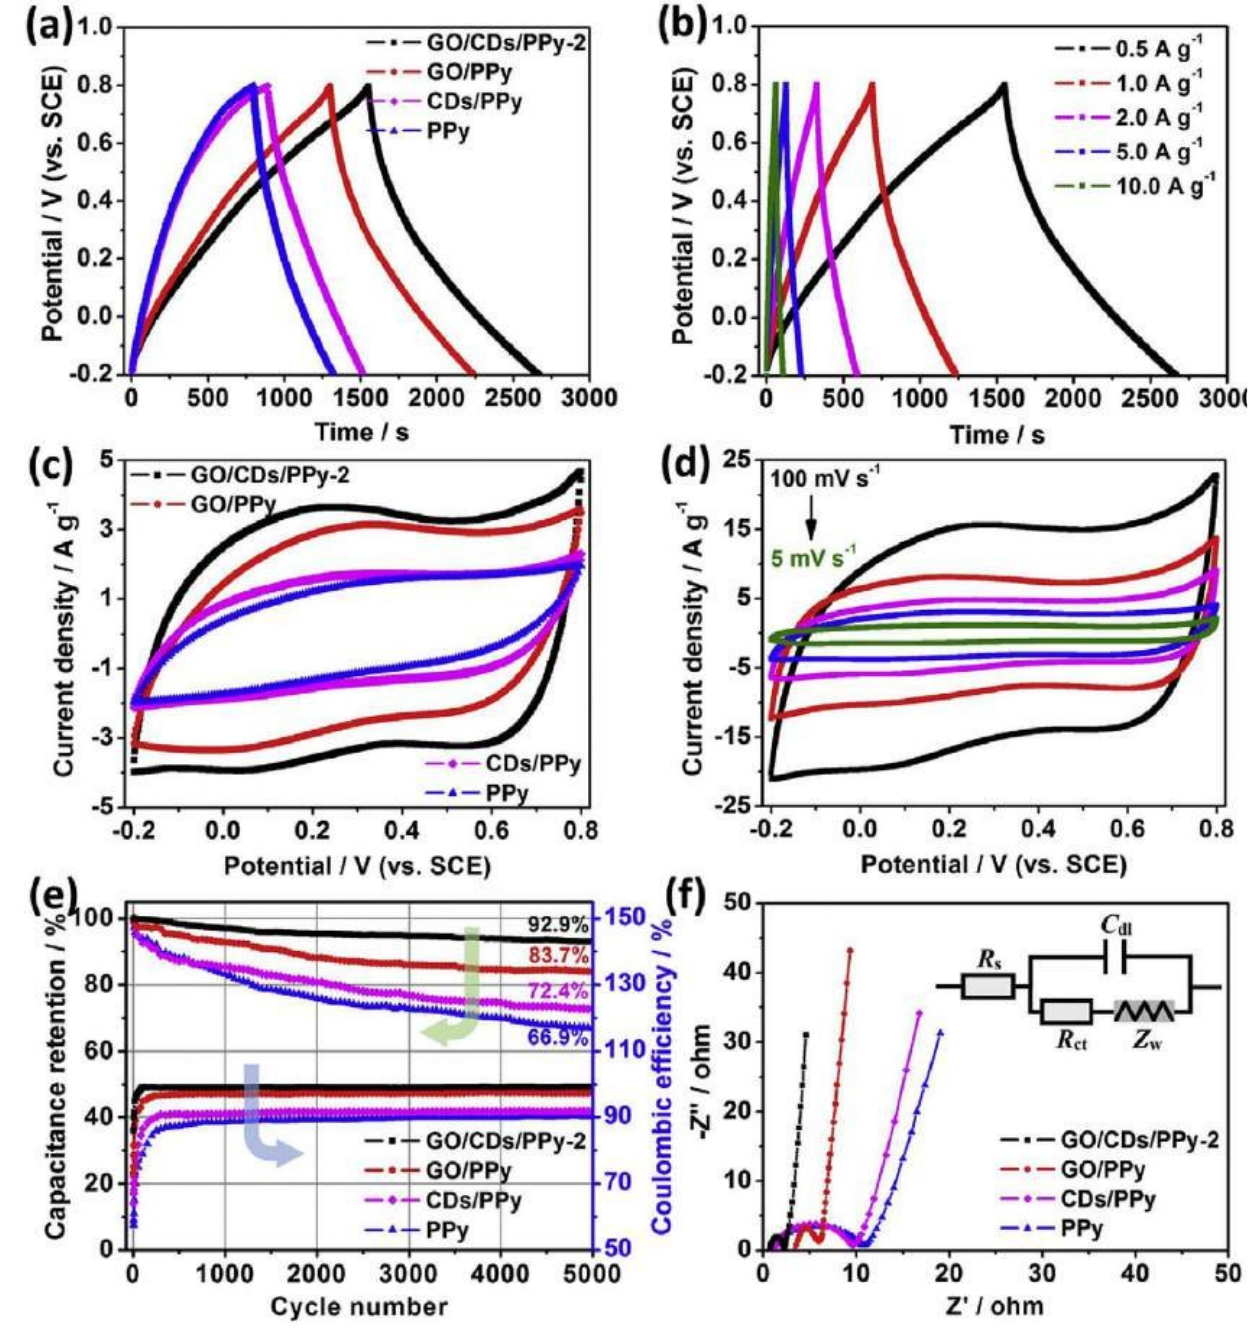
Figure 24. Investigation of the electrochemical properties of PPy, CDs/PPy, GO/PPy, and GO/CDs/PPy composites: ( a ) GCD curves at 0.5 A g − 1 current density; ( b ) GO/CDs/PPy GCD curves at various current densities; ( c ) CV curves at 10 mV s − 1 scan rate; ( d ) GO/CDs/PPy CV curves. Reproduced with permission from [104]; ( e ) Cycling stability; ( f ) Nyquist plots. The inclusion of PPY and SnO2 in the compositegives both EDL capacitance and apparent pseudocapacitance, as demonstrated by the redox peak. The large-area re- dox peak is caused by the combined impact of SnO2, GO, and PPY. CV curves of the SnO2QDs/GO/PPY composite at scan speeds ranging from 10 to 40 mV s − 1 are shown in Figure 25a–f. The maximum Csp estimated from the SnO2QDs/GO/PPY composite is 1296.14 F g − 1 : as the scan rate increases, the Csp decreases, indicating a higher rate